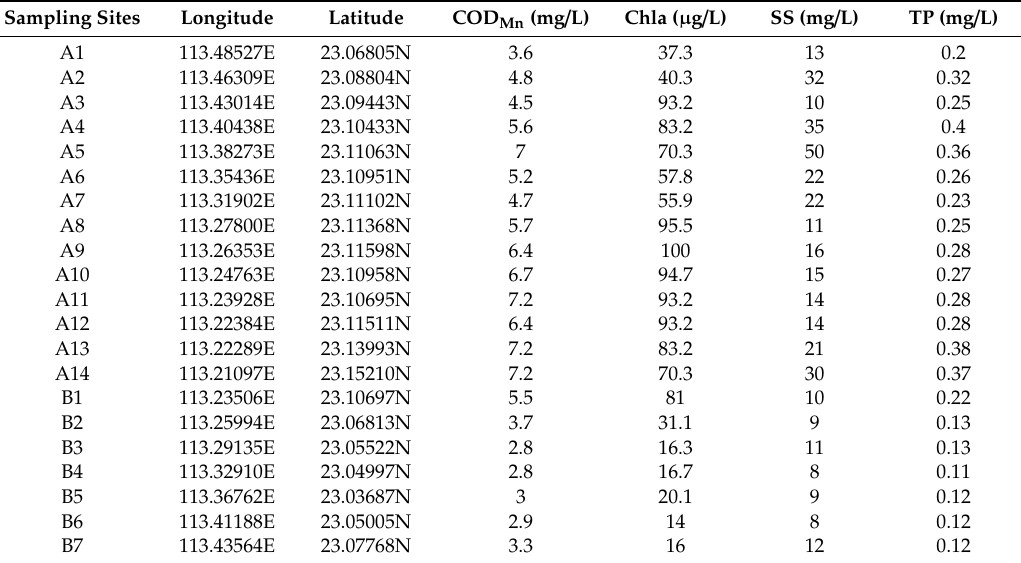
Table 3. Water quality analysis results for each sampling